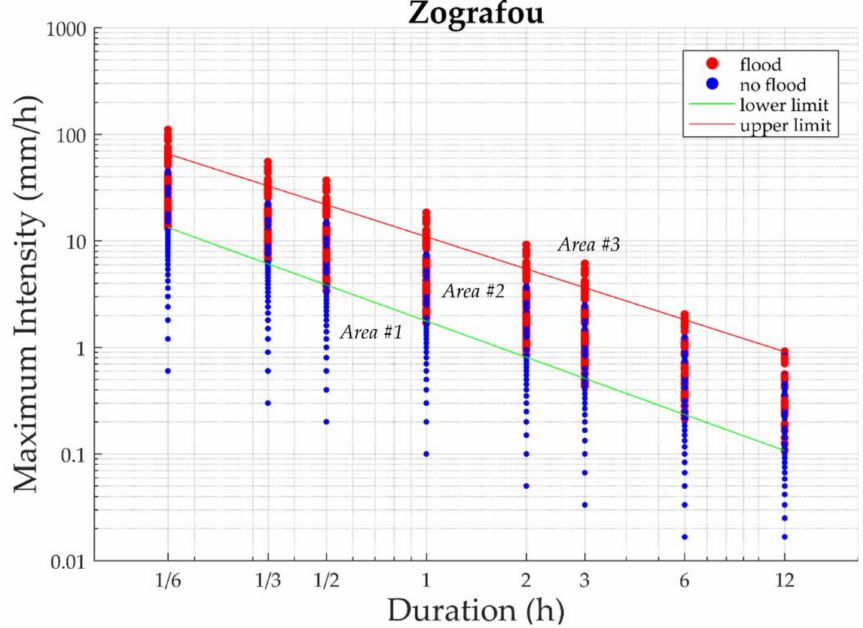
Figure 2. Maximum rainfall intensity–duration (ID) diagram for “Zografou” station (ID thresholds and limits of areas #1, #2, and